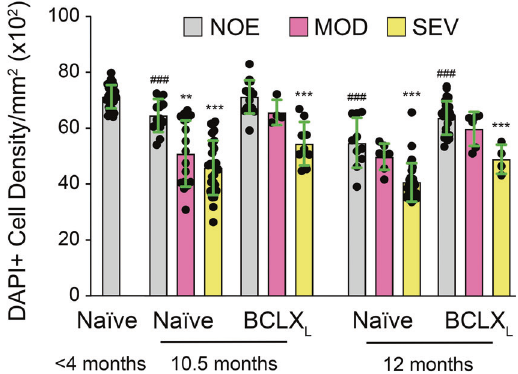
Fig. 8 Correlation between retinal total cell density and optic nerve degeneration score. Eyes for which there was both an optic nerve score and analysis of the total neuronal cell density present in the retina were used to evaluate the symmetry of both RGC soma loss and axon loss in the same eye. Total cell counts re fl ect both RGC and amacrine neuronal populations in the ganglion cell layer. Combined scatter plot/bar graphs (mean ± standard deviation) are shown. In all cohorts (naive and BCLX L treated, aged 10.5 or 12 months), cell density was signi fi cantly lower in eyes with SEV optic nerves compared to eyes with NOE optic nerves in the same cohort (Student ’ s t test, *** P < 0.0001). Also, within cohorts, eyes exhibiting MOD optic nerves had no signi fi cant change in cell density, compared to eyes with NOE optic nerves, with the exception of naive mice aged to 10.5 months (** P = 0.0006). Compared to young naive mouse eyes with NOE optic nerves, most aged cohorts had modestly reduced cell densities in the NOE populations (on average a 10% reduction, ### P < 0.001), with the exception of BCLX L -treated eyes at 10.5 months, which showed no signi fi cant change. The distribution of mice for each cohort (M/F) was: <4 (6/10); 10.5 Naive (17/12); 10.5 BCLX L (10/5); 12 Naive (12/11); 12 BCLX L